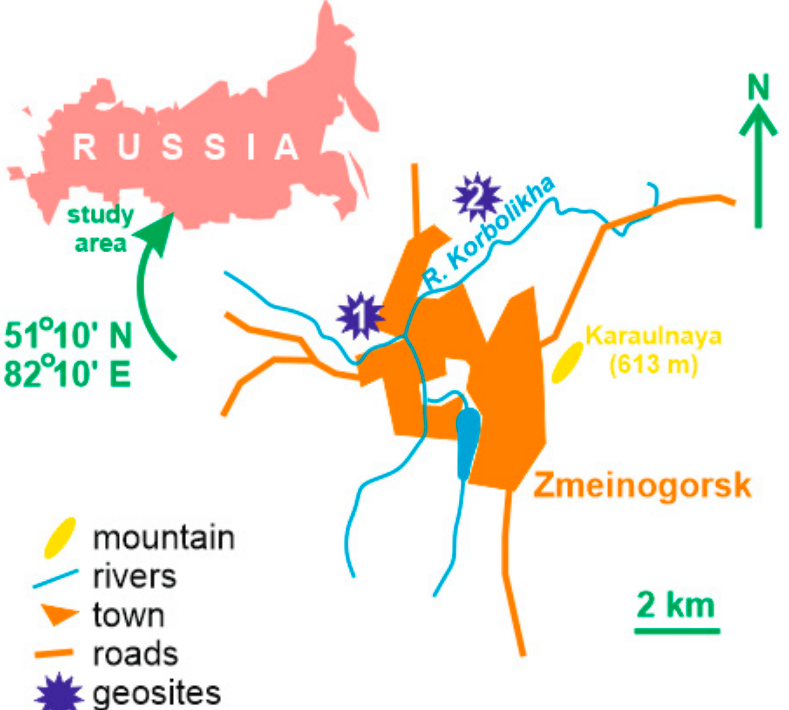
Figure 1. Location of the study area and the proposed geosites; 1. Melnichnye Sopki and 2. Zavodskie Sopki.